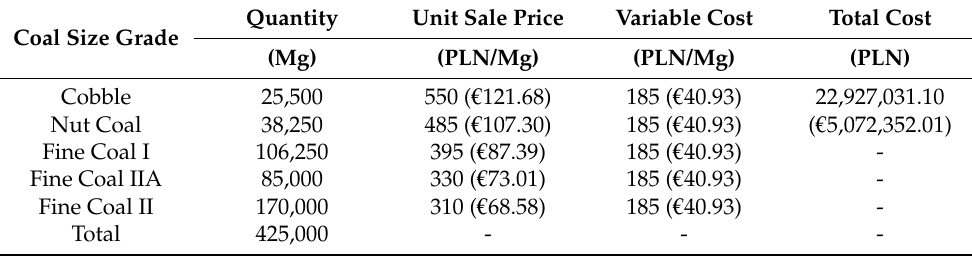
Table 3. Assumed value of production and economic indicators of mine “X” in a monthly take. Coal Size Grade